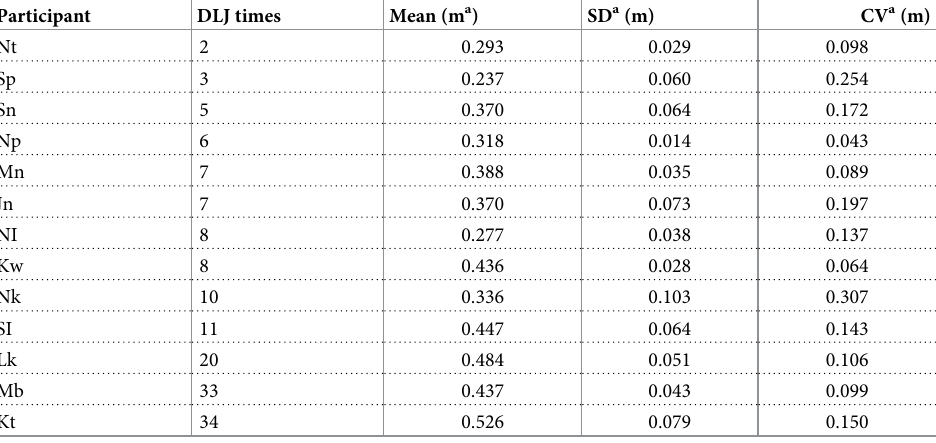
Table 3. BCOM height differences in the DLJ of